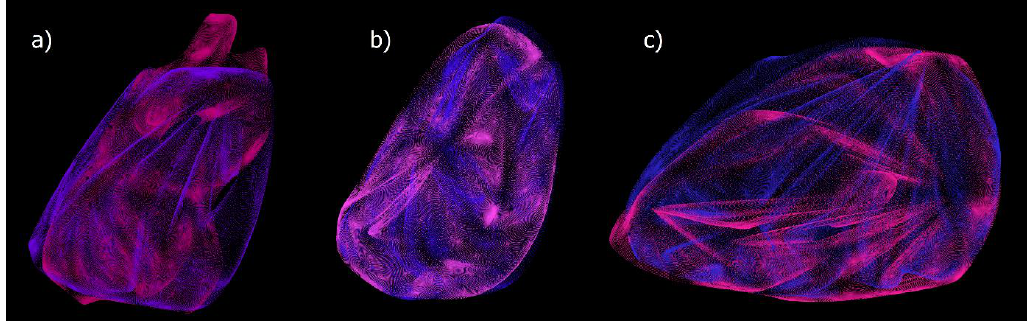
Figure 8. Superimposition of dough surface with (pink) and without induced aerosol (purple) of three different dough objects a, b, c.